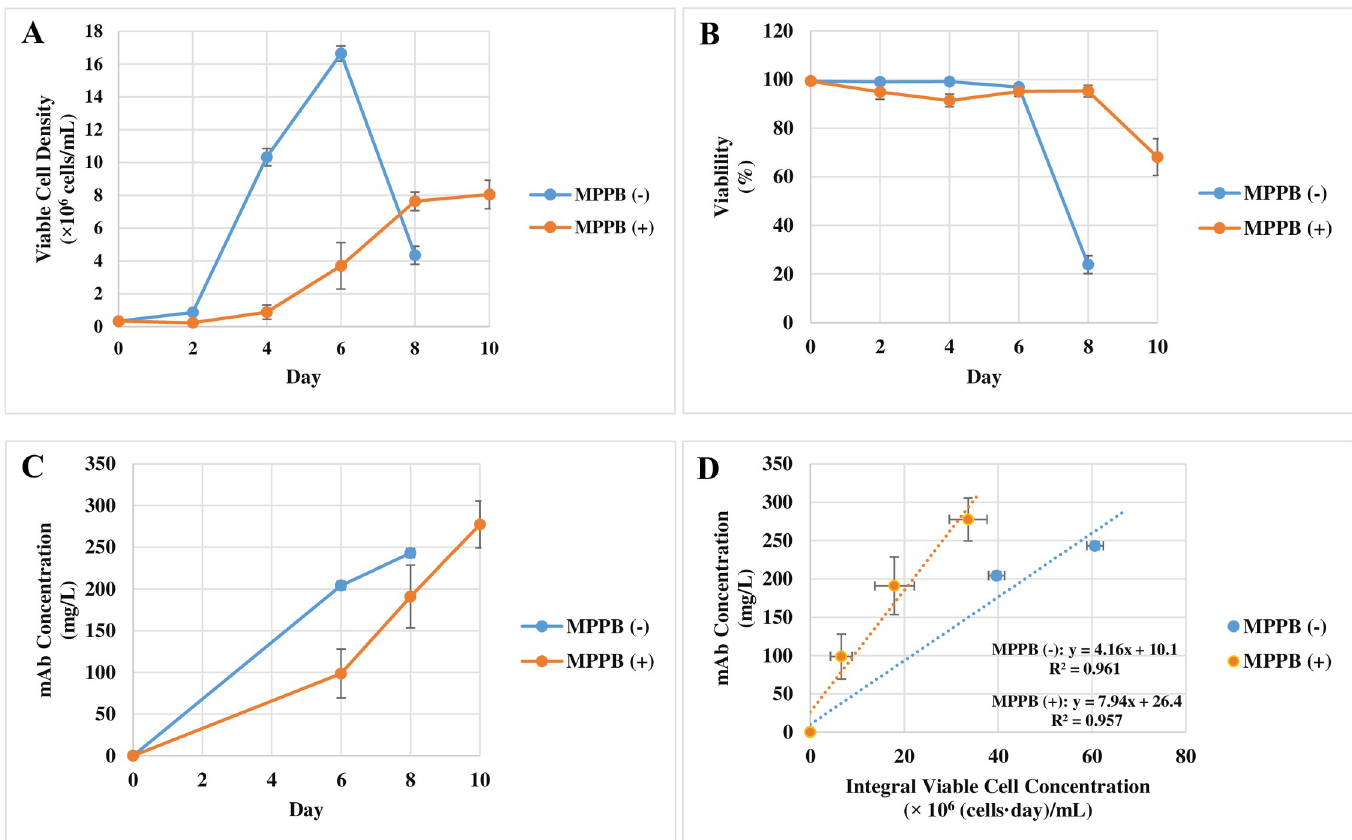
Fig 7. Cell culture profile and mAb production in rCHO cells treated with MPPB. MPPB at 0.64 mM was added in the batch cultures on day 0. Viable cell density ( A ) and viability ( B ) were measured every 2 days. Cell culture was continued until viability below 70% was reached. The slope of mAb concentration ( C ) to integral viable cell concentration was used to indicate cell-specific productivity ( D )